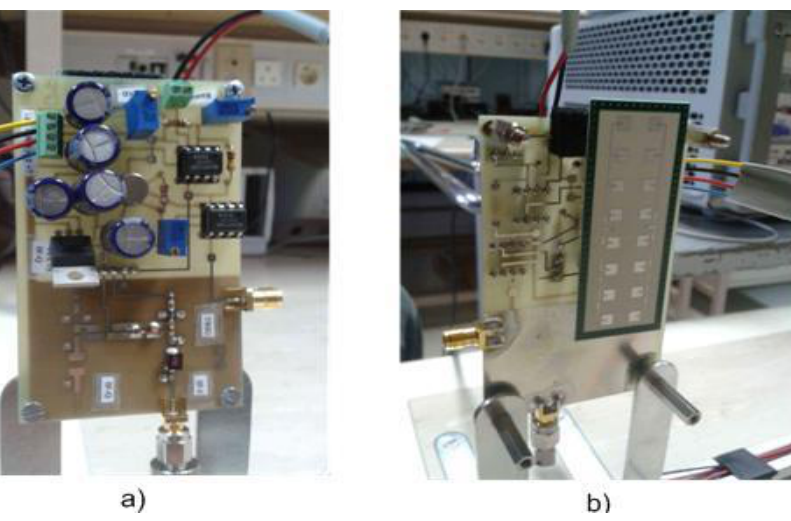
Figure 9. Radar network: ( a ) Back-view single sensor ( b ) Front-view single sensor ( c ) Radar network with three